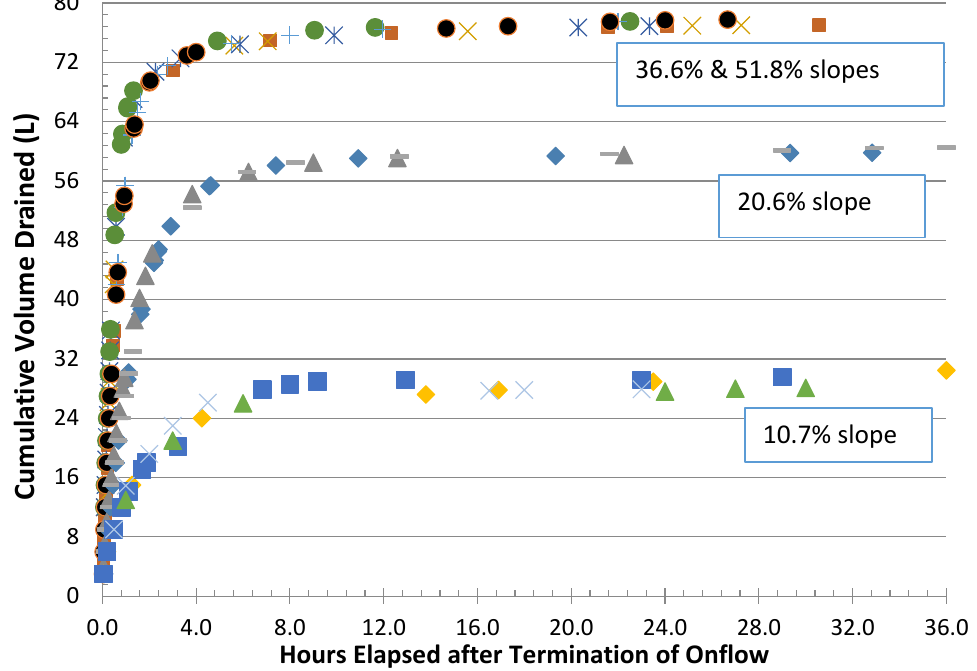
Figure 11. Measured rates of drainage as they depend on bedslope for 143 mm sand depth.